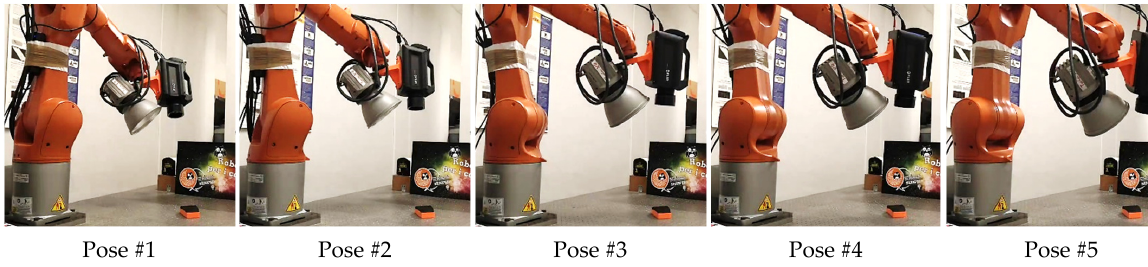
Figure 8. Robotic inspection system during data acquisition for the first five poses.